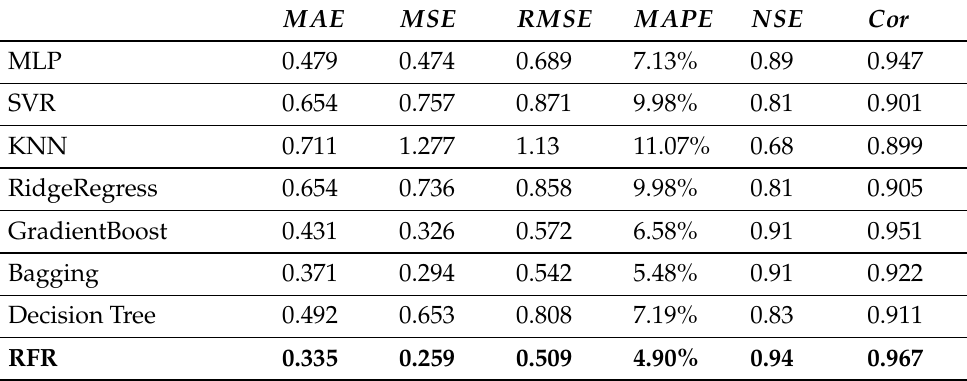
Figure 6. Cor for Ensemble learning methods: ( a ) Random Forest. ( b ) Gradient Boosted Regression Tree.( c ) Bagging.( d ) Decision Tree. Table 3. Evaluation results for predicting inland water